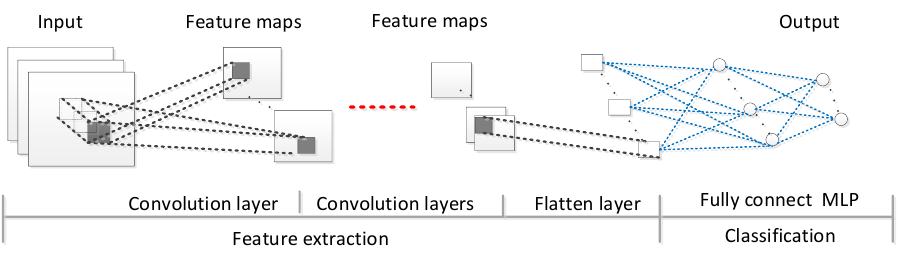
Figure 5. Illustration of the process of deep learning used for VSE.